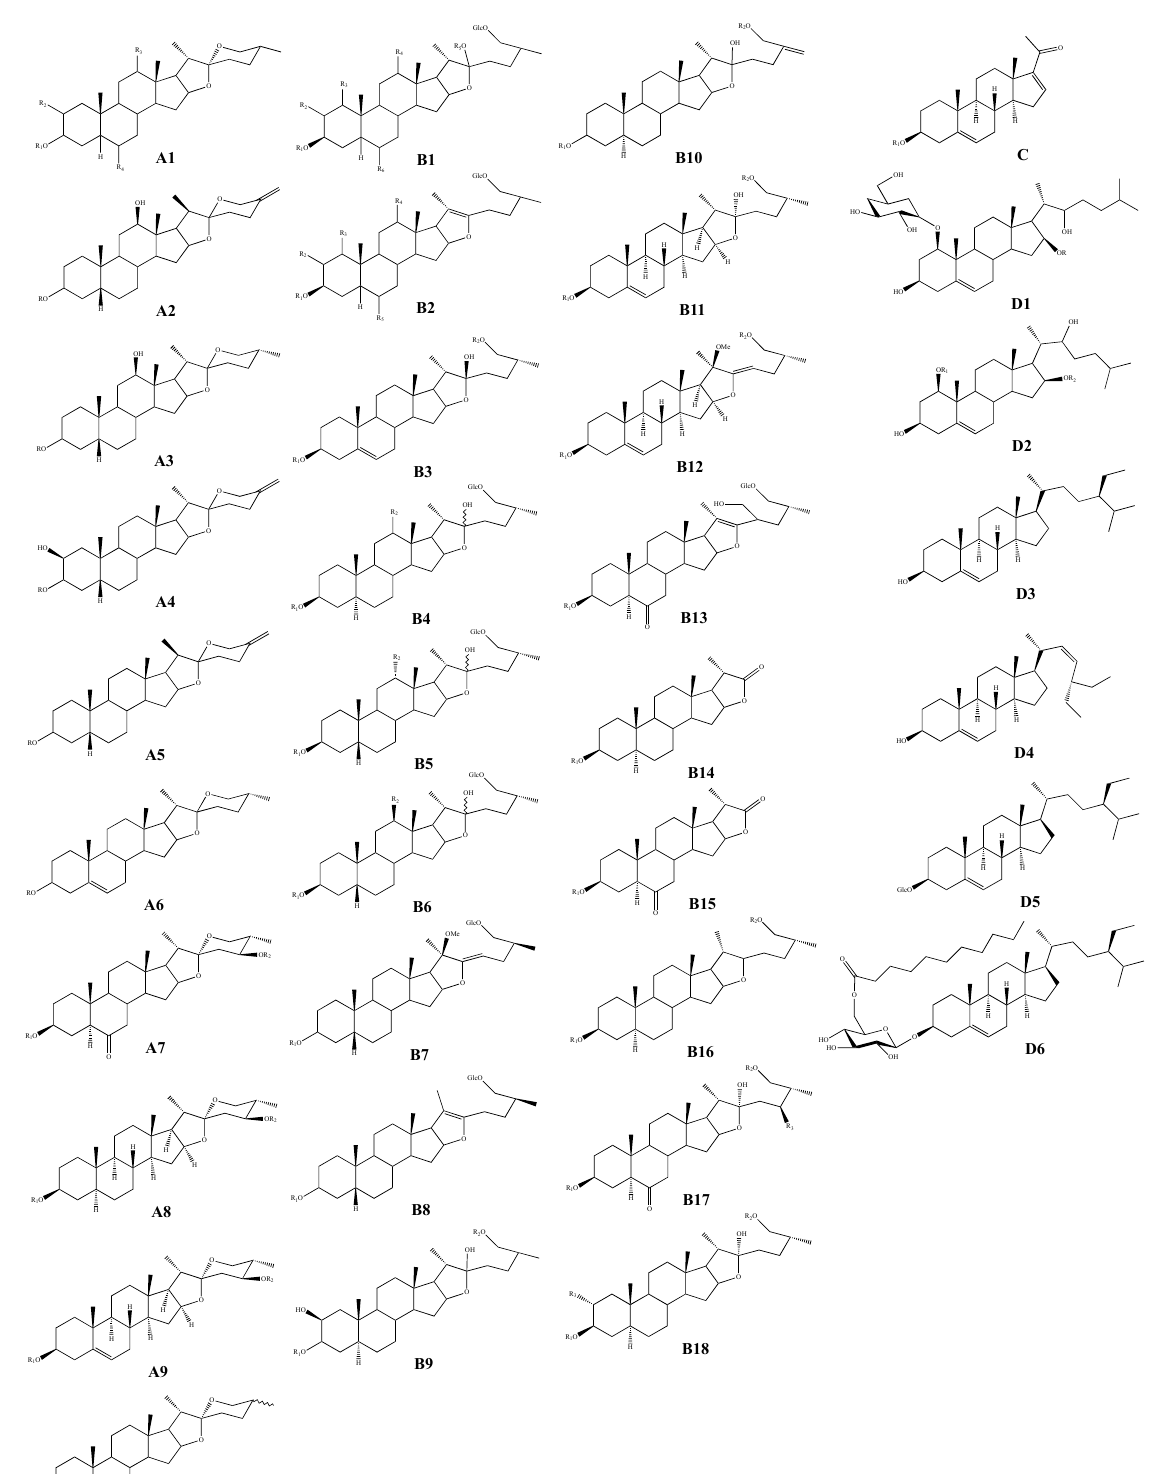
Figure 2. Structure of steroids and steroidal saponins isolated from AMB.